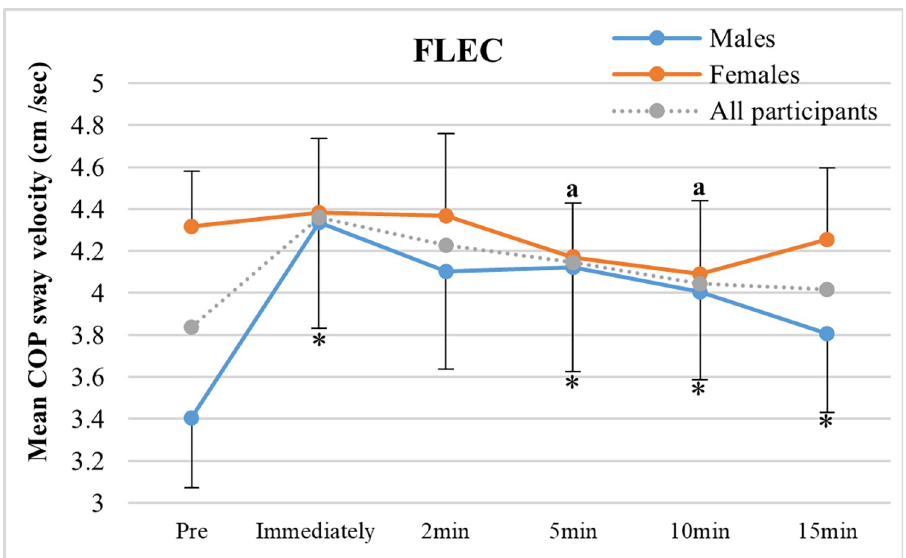
Fig 4. Sex differences in fatigue effects on mean COP sway velocity. Mean COP velocity shown before, immediately following exercise, and throughout the recovery period (2, 5, 10, and 15 min) in males and females during the standing forward leaning task with eyes closed (FL-EC). � = fatigue effects for males and females ( p � 0.05, compared to pre- exercise), and a = sex X fatigue interaction (p � 0. 05, in comparing percentage changes from pre to post-exercise between males and